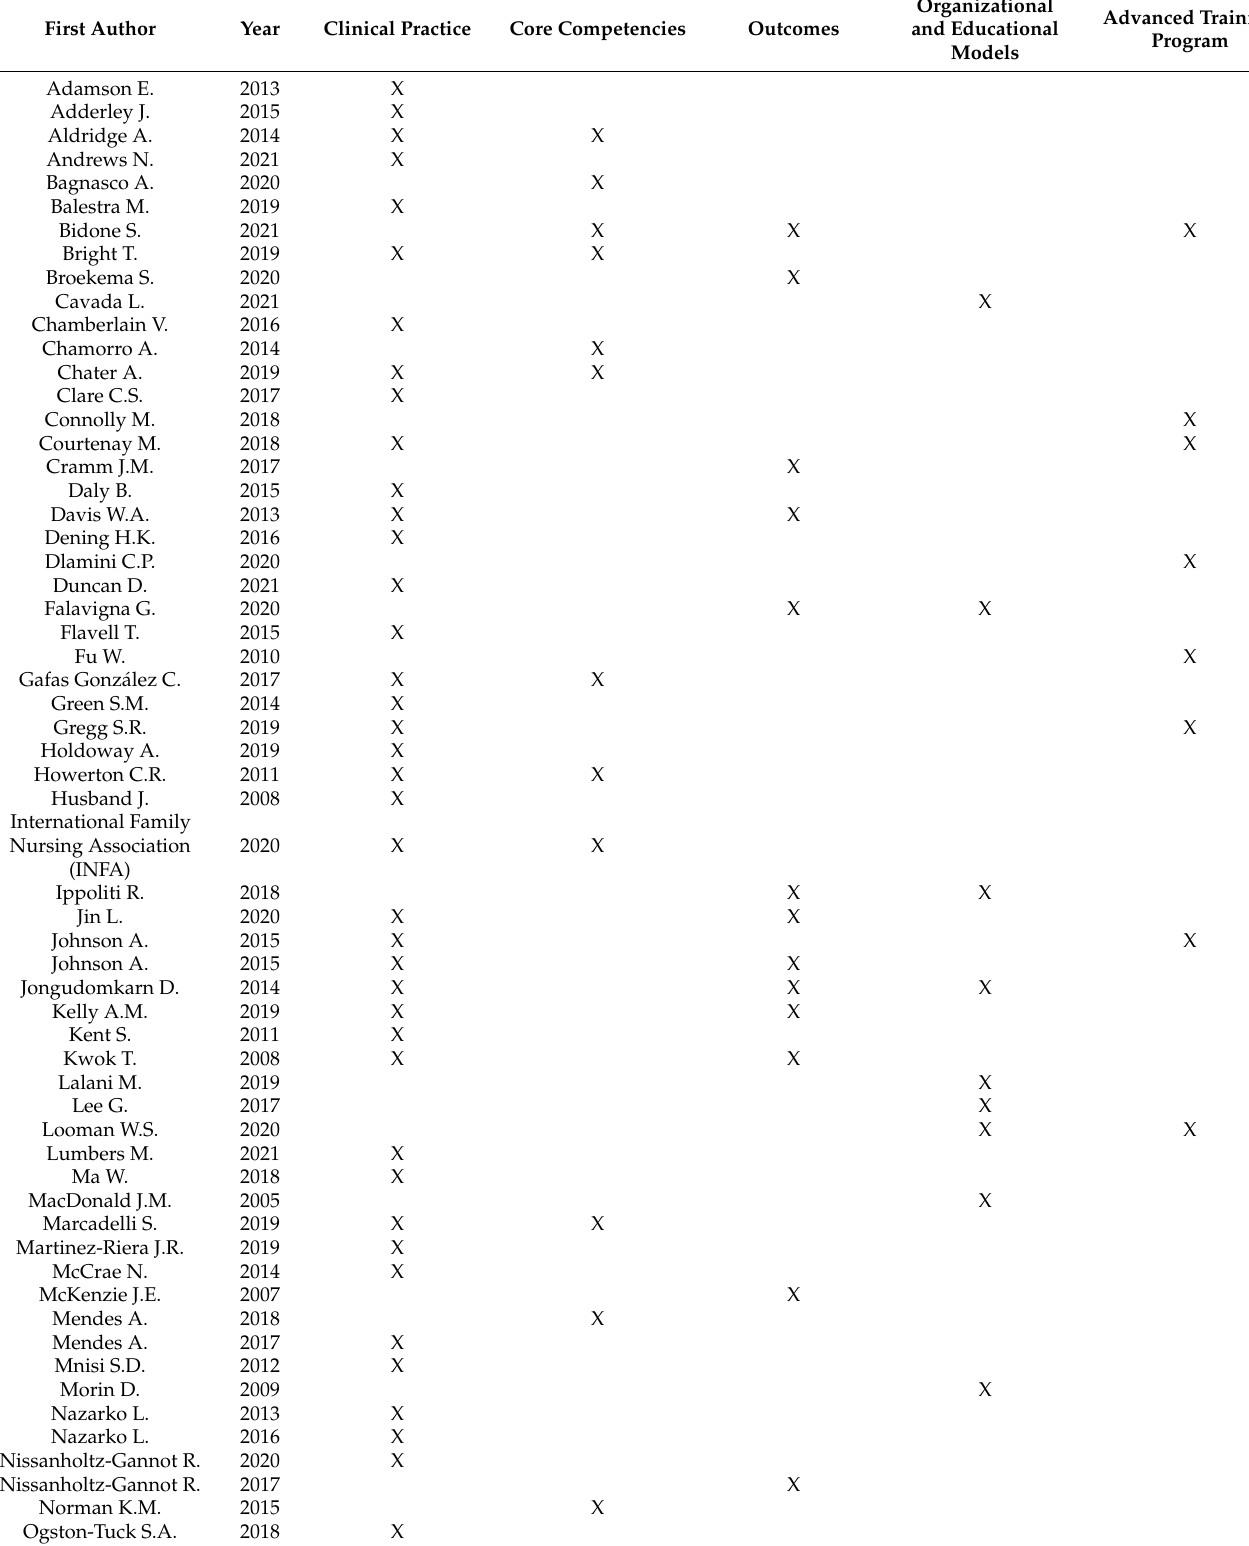
Table 1. Aggregation between included studies and interpretative themes arising from the